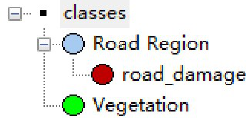
Figure 7. Class Hierarchy